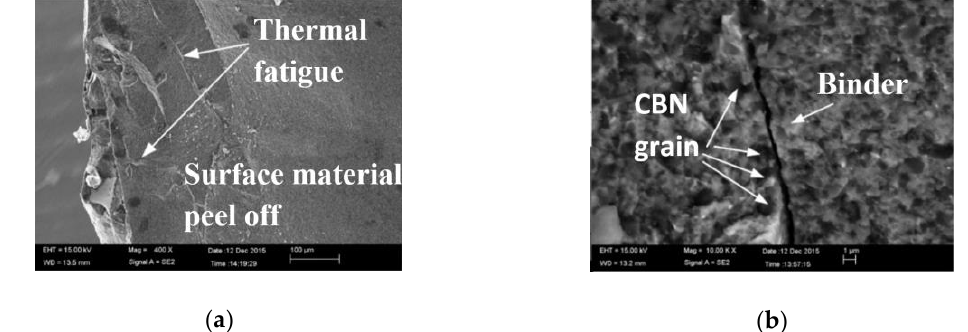
Figure 13. The microscopic morphology of the PCBN tool rake face after the peeling of the surface material: ( a ) Microscopic morphology; ( b ) Tool rake face fatigue crack morphology.